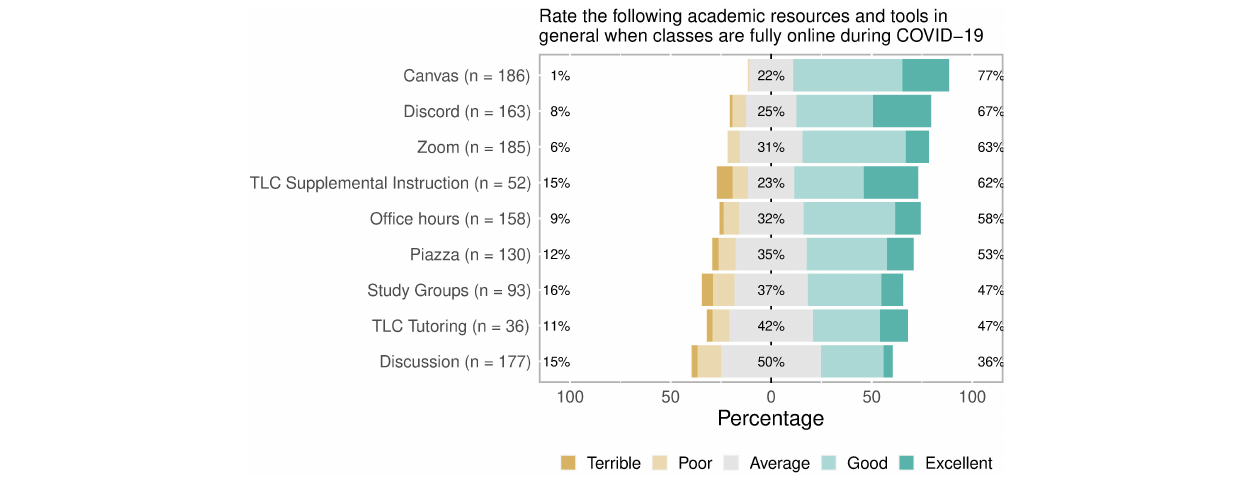
34% neither agreed nor disagreed, and 26% disagreed/ strongly